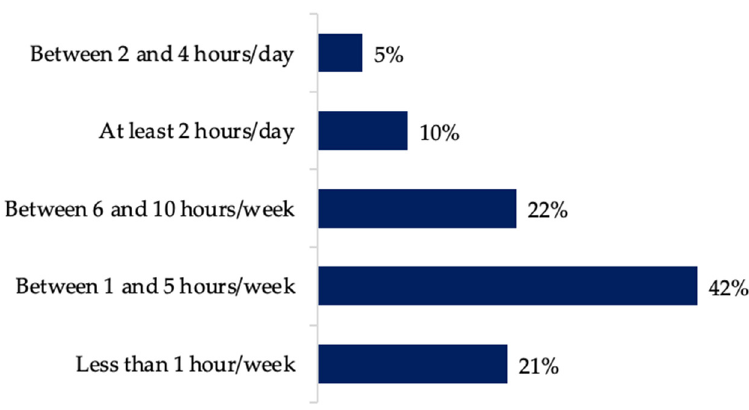
Figure 5. Time farmers spend managing data and/or performing data Figure 4. Time farmers spend managing data and/or performing data analysis.